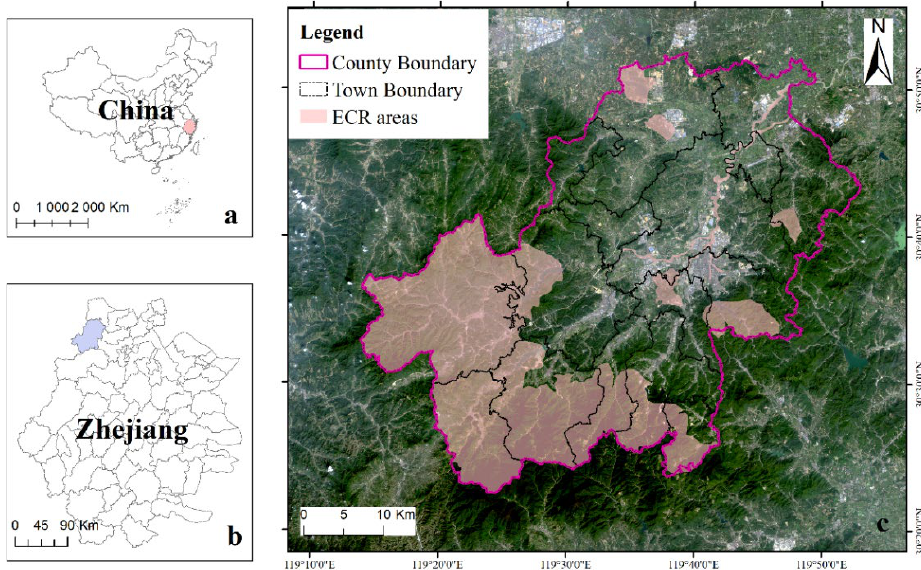
Figure 1. Location of Zhejiang Province in China ( a ), Anji County in Zhejiang Province ( b ) and the distribution of ECR in Anji county ( c ).